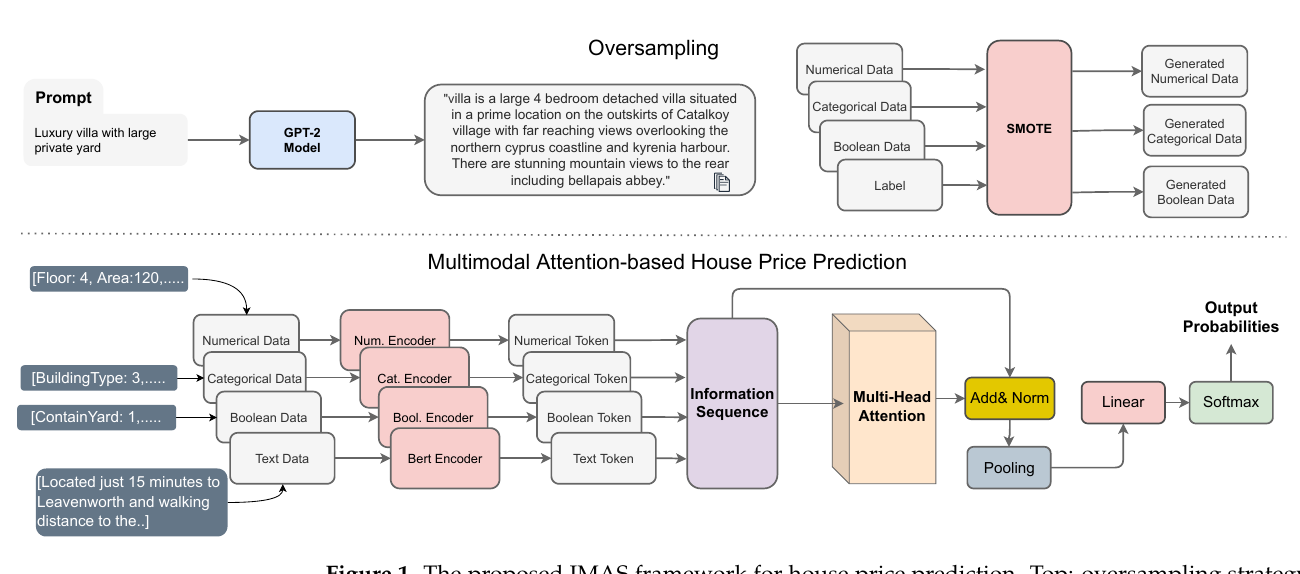
Figure 1. The proposed IMAS framework for house price prediction. Top: oversampling strategy applied to all types of features. Bottom: